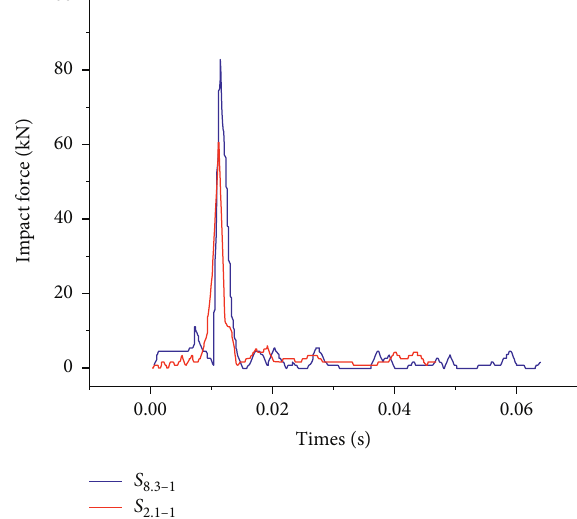
Figure 18: Time chart of impact forces at different impact heights of the column.